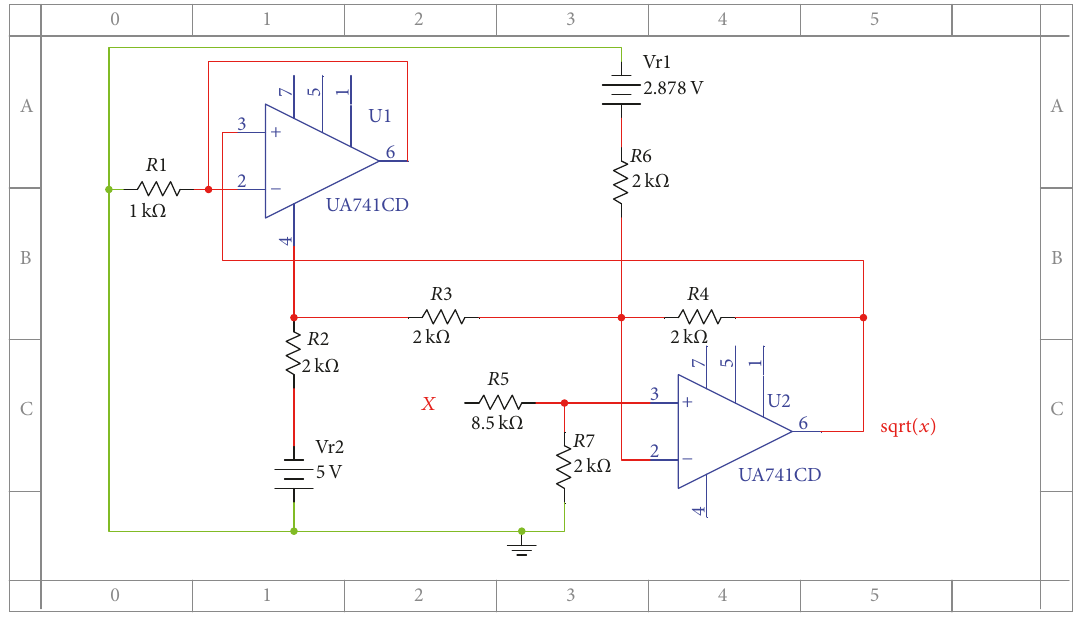
Figure 7: Circuit design of the square root function with